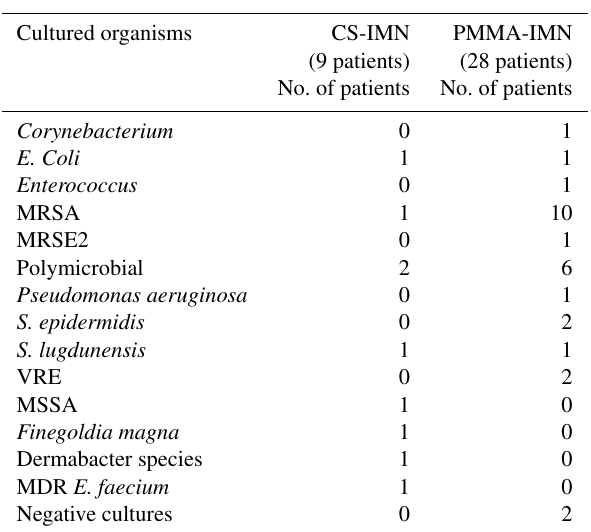
Table 3. Results of intra-operative cultures at our index surgery in the active infection treatment